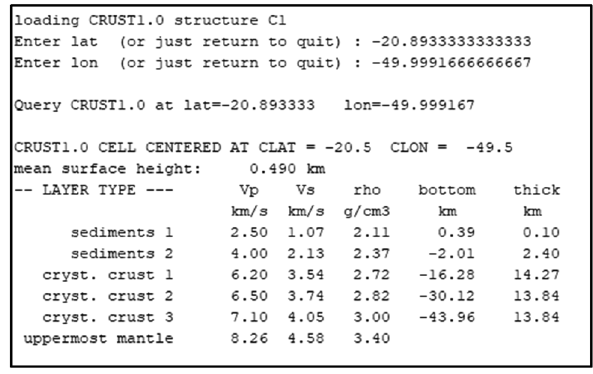
Figure 5: Example of CRUST 1.0 values at a given point around the PPTE